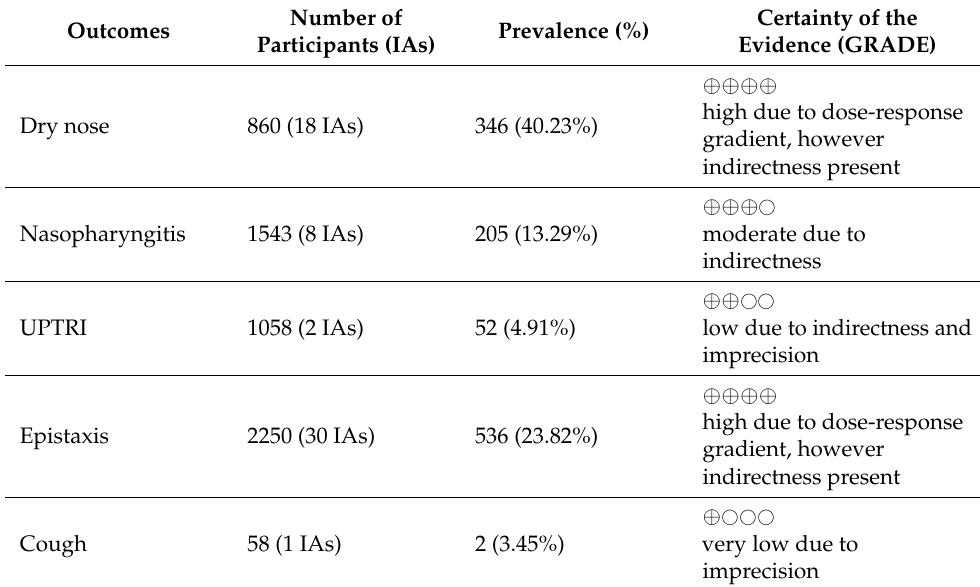
Table 5. Summary of ISO therapy adverse events: nasopharyngeal changes.